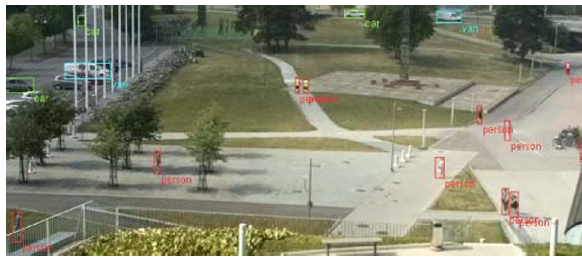
Figure 6: Camera view from the test setup running real time object detection on a Raspberry Pi platform.